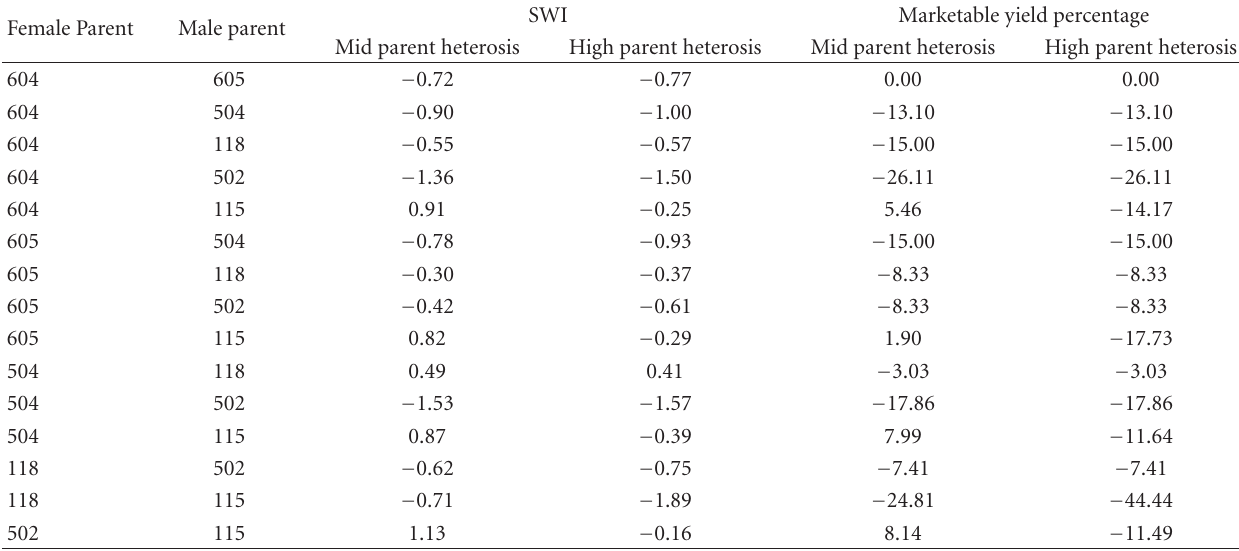
Table 7: High parent heterosis and mid parent heterosis for SWI and marketable yield percentage. Female